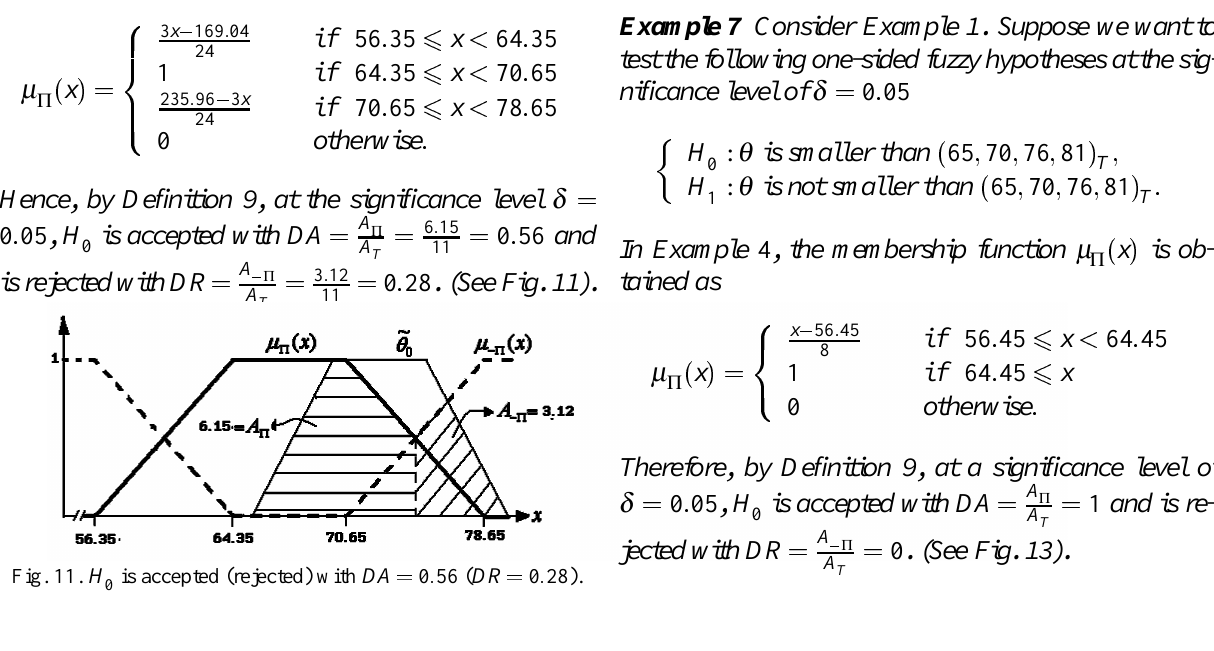
is accepted (rejected) with DA 0